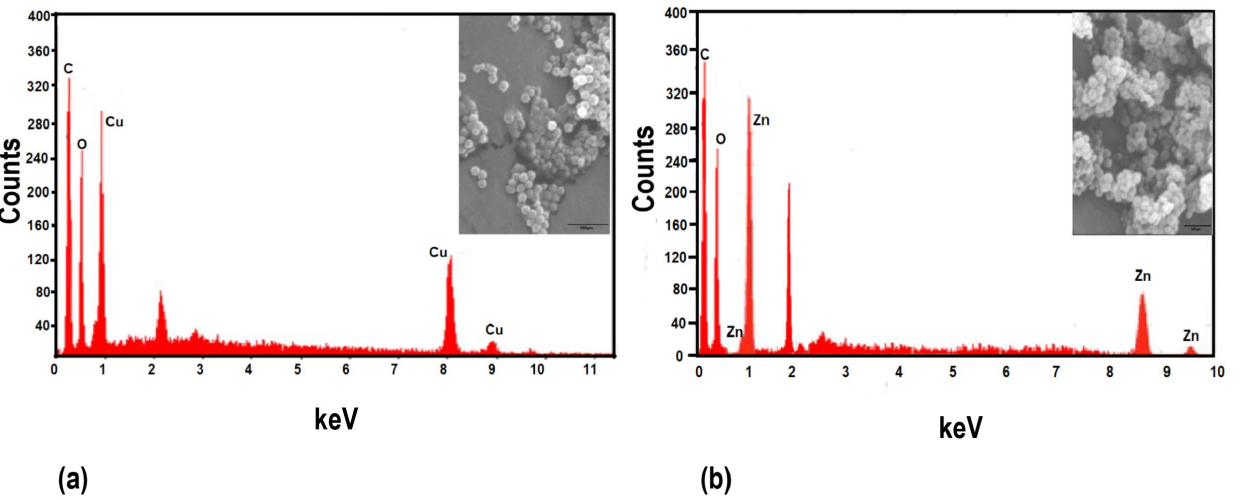
Figure 3. Energy dispersive X-ray diffraction spectrum for ( a ) CuO nanoparticles and ( b ) ZnO nanoparticles. Inset are scanning electron microscopy images of ( a ) bacteriogenic CuO nanoparticles ( b ) bacteriogenic ZnO nanoparticles using JEOL JSM-7600F FEG-SEM with a scale bar of 500 µ m. The average grain size of the CuO and ZnO was calculated from the full width at half maximum (FWHM) of the diffraction curves by using the Debye–Scherrer formula, [49,50] k λ D = β cos θ where D is the particle size; K—Scherrer constant (0.9); λ —wavelength of X-ray radiation (0.15406 nm); β —full width at half maximum (FWHM) of the XRD peak; θ —Bragg’s angle. Using the Debye–Scherrer equation, the average grain size of the CuO and ZnO nanoparticles were determined as 38.96 nm ( ± 5) and 42.64 nm ( ± 3), respectively (Table 1). The particle size for CuO and ZnO nanoparticle ranged between 50 and 100 nm as confirmed by transmission electron microscopy (JEOL-2100TEM) (Figure